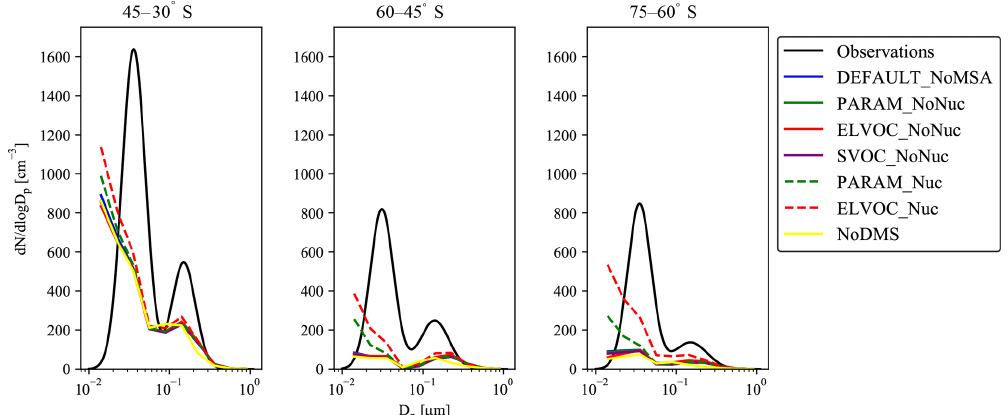
Figure 7. Comparison of simulated annual mean particle number size distributions to the annual zonal particle number size distributions compiled in Heintzenberg et al. (2000) (black lines) for the southern oceans. No data were available in Heintzenberg et al. (2000) for 75– 90 ◦ S. We match the grid boxes sampled in their study to the GEOS-Chem-TOMAS grid boxes; due to sparseness of data, we do not attempt to discuss seasonal variabilities in this